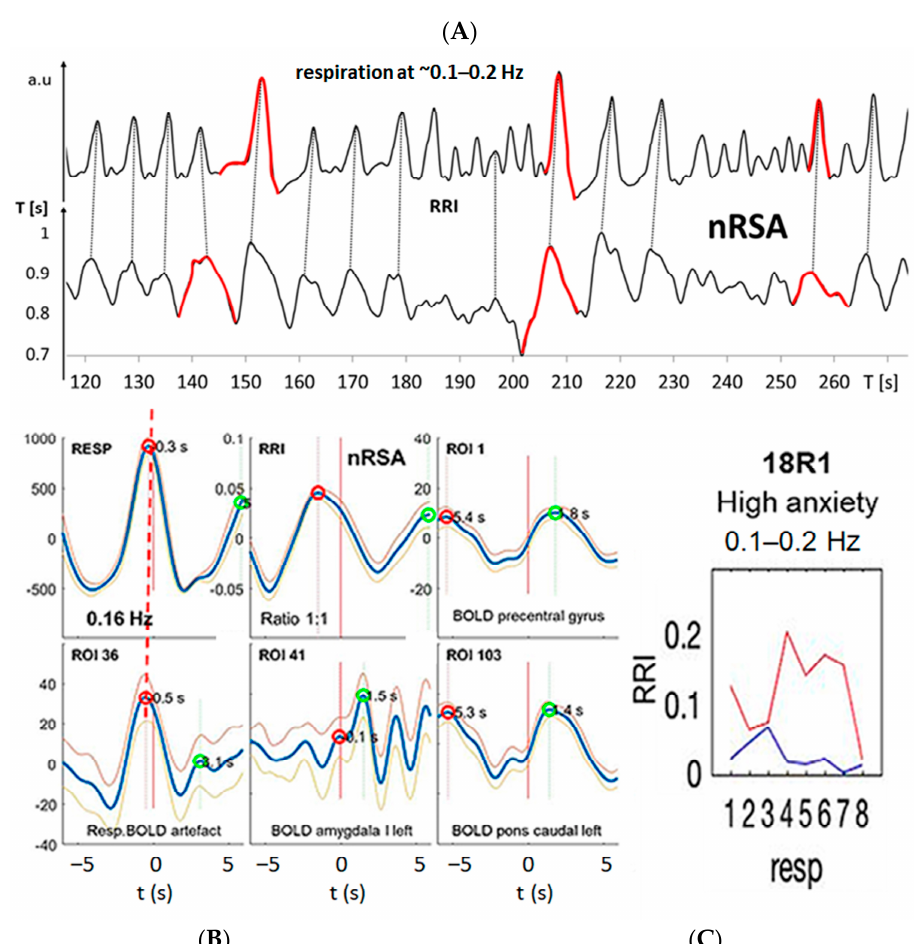
Figure 4. Example from subject #18. ( A ) Records of respiratory (upper trace) and RRI waves (lower trace); abscissa: time [s]. Some respiratory and RRI periods with PD transitions are marked in red. Note that transitions in the RRI rhythm precede the changes in the respiratory rhythm. ( B ) RRI peak (longest RR interval)-triggered respiratory (resp), RRI and slow BOLD waves (mean ± SEM; more details see text). Note the fast oscillation in the amygdala (lower line, middle panel). ( C ) Information flow is predominant from RRI to respiration; for further explanations, see Figure 3.